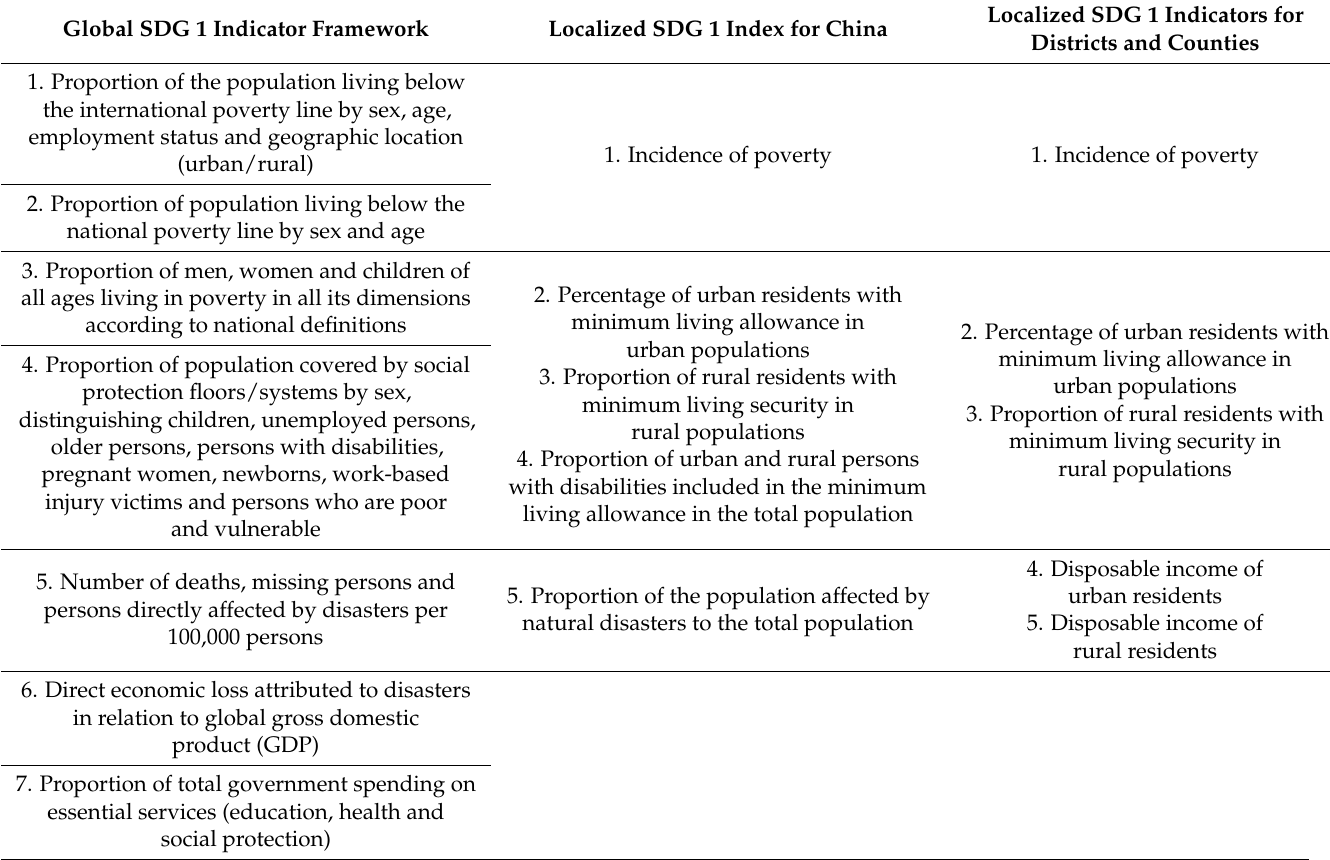
Table 1. Localized, SDG 1 index system for districts and